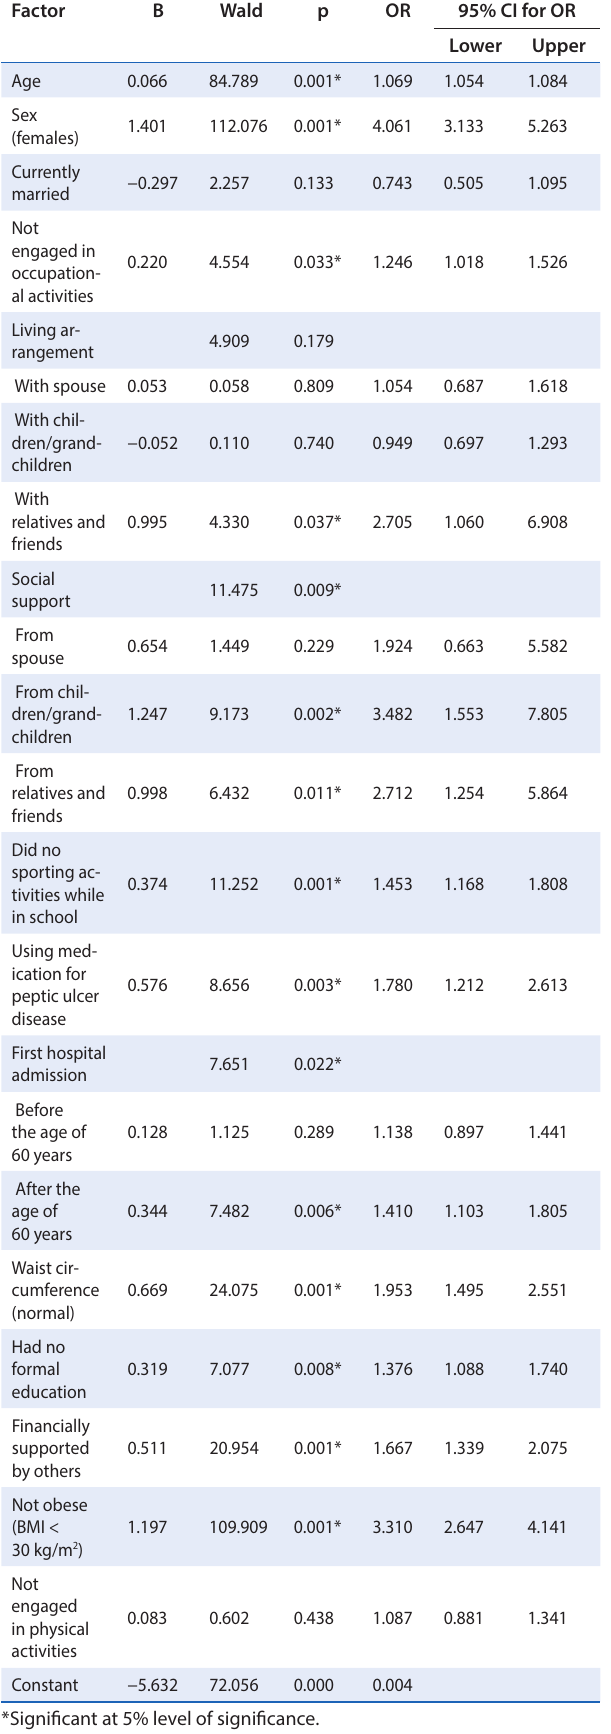
*Significant at 5% level of significance.